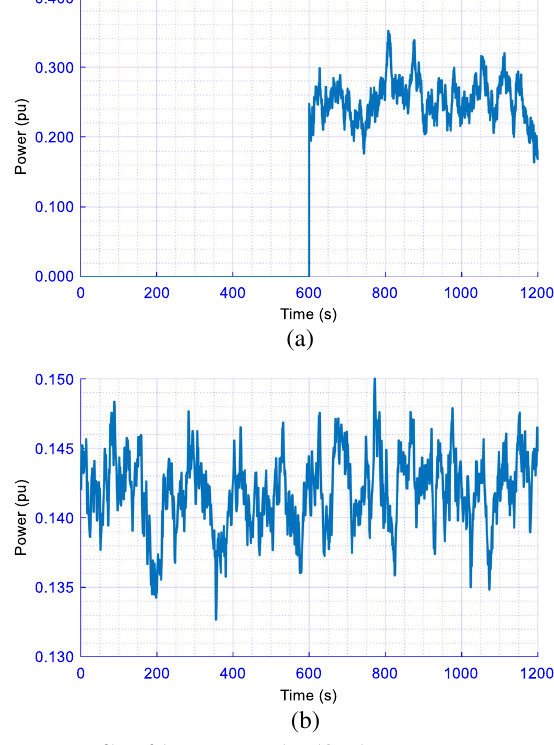
Fig. 11 Profiles of the RESs: a wind and b solar power